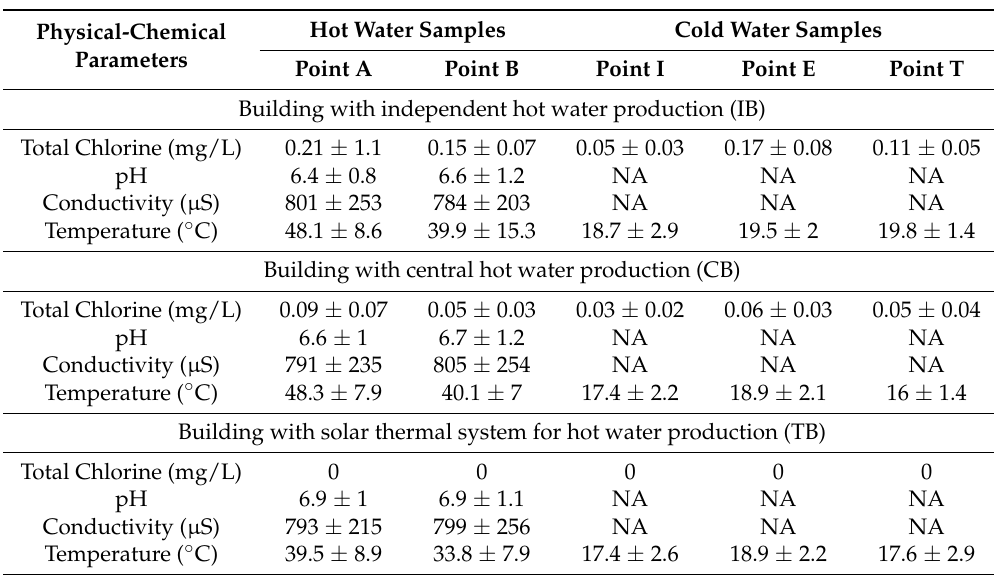
Table 1. Mean values of physical-chemical parameters (total chlorine, pH, conductivity, and temperature) detected in hot and cold water sampled at different point of use (Point A, Point B, Point I, Point E, and Point T) of the buildings IB, CB and TB. NA = Not